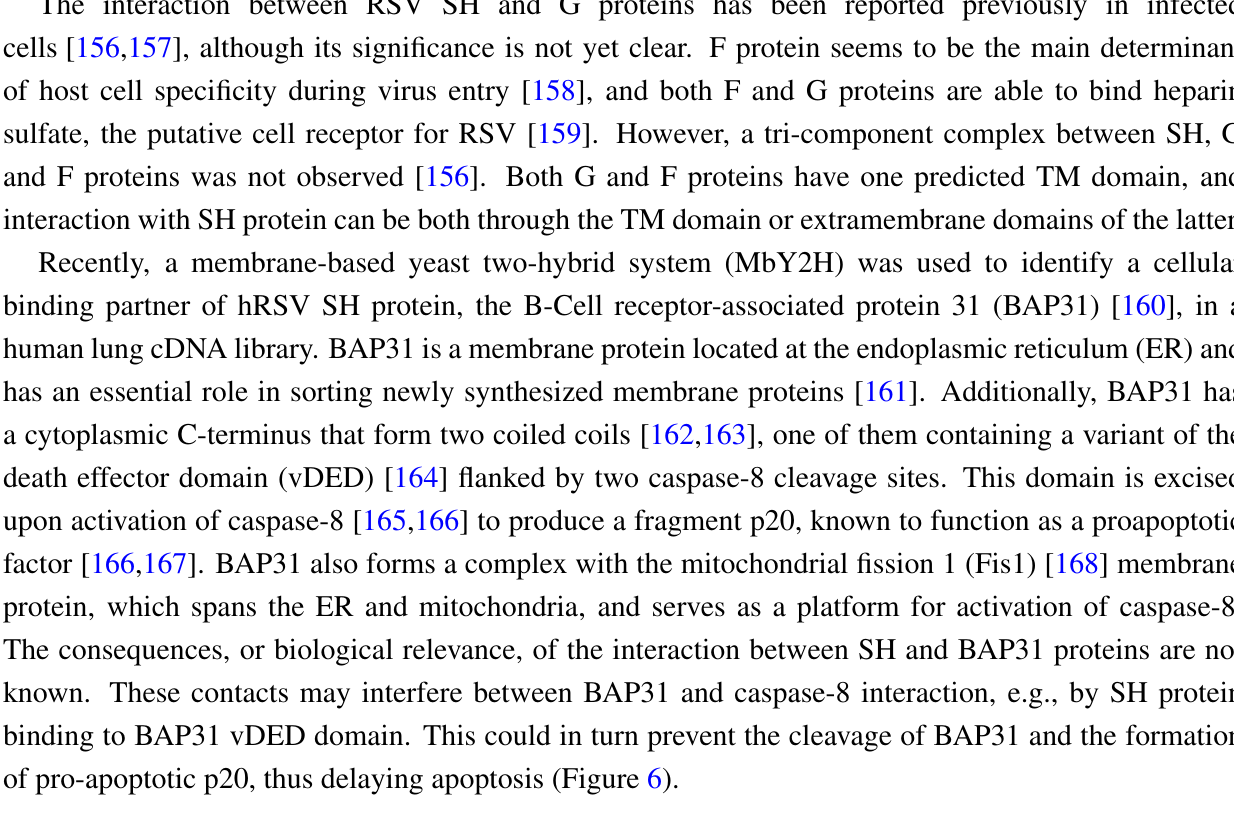
Figure 5. Alignment between SH protein for strains A2 and S2 (group A), B1 (group B)